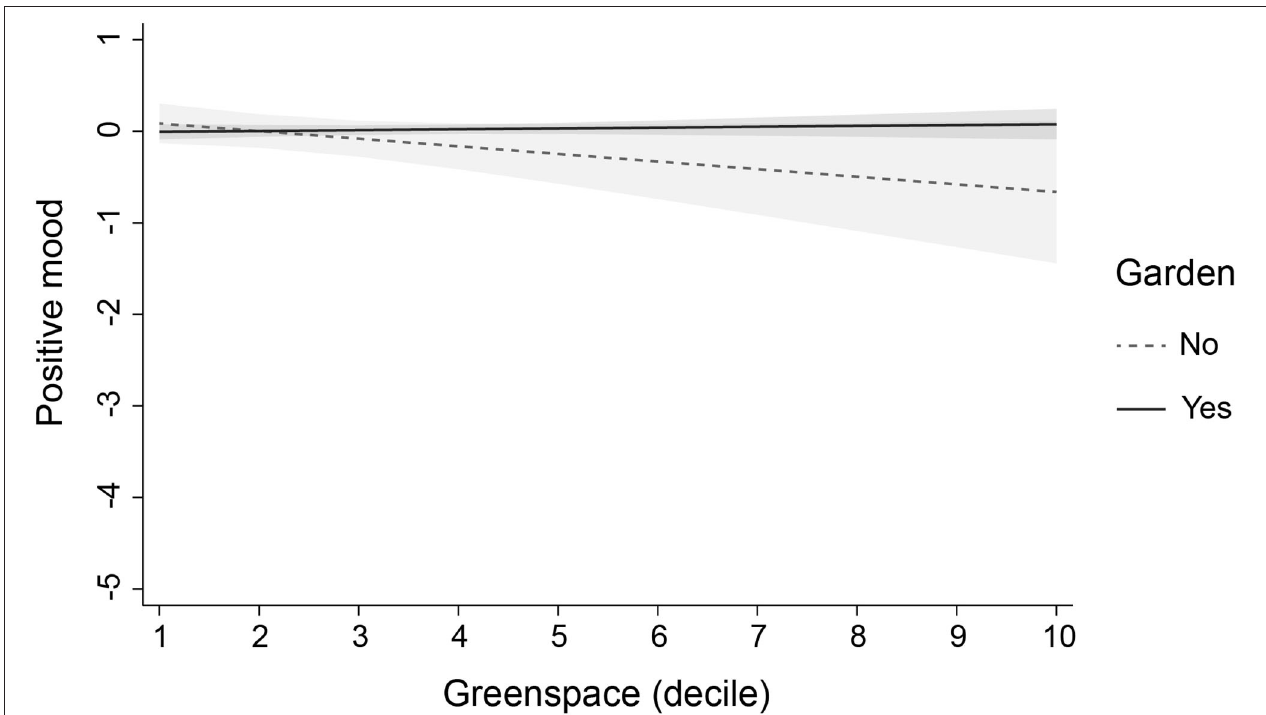
FIGURE 2 | Modification of the effect of greenspace on positive mood by garden access. This plot illustrates the modifying role of garden access in the association of greenspace with positive mood (linear predictions). Plots are based on non-imputed data. Shaded areas are 95% confidence